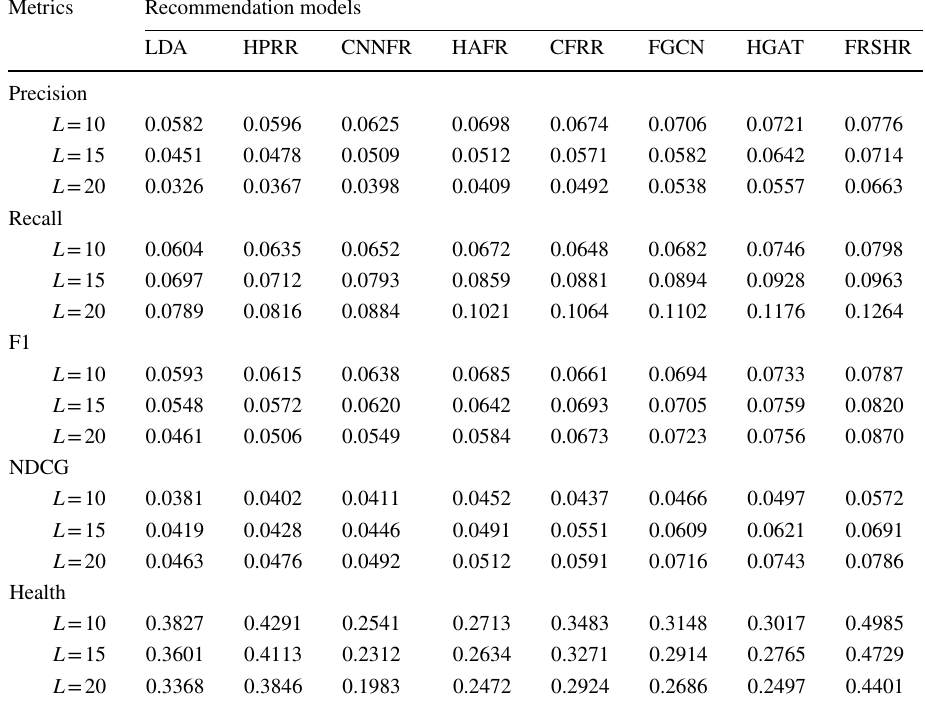
Table 4 The efficiency of the developed FRSHR model compared to other recommendation models in terms of different lengths of recommendations list (